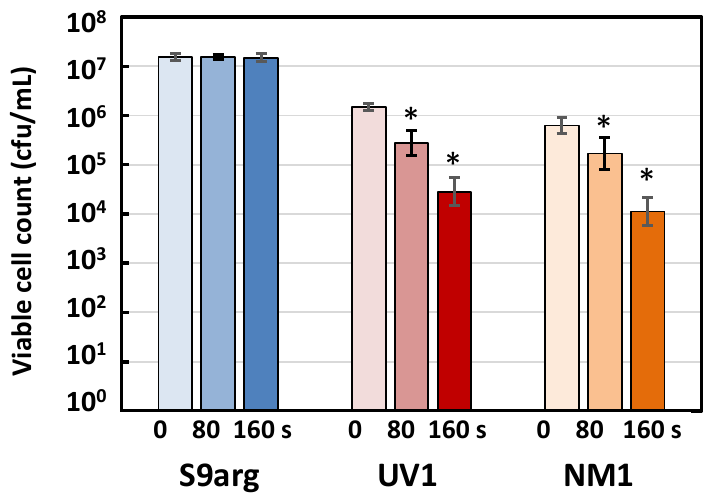
Figure 7. The viable cell counts of strain S9arg and its piezosensitive mutant strains UV1 and NM1 after HHP treatment at 200 MPa at ambient temperature for 0 s, 80 s, and 160 s. Values are presented as mean ± standard deviation from three independent experiments. For each strain, significant difference ( p < 0.05) of the viable ell count with HHP treatment for 0 s are indicated with asterisks.